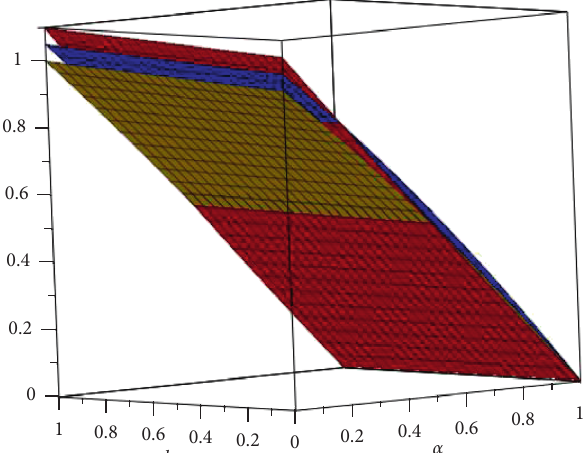
Figure 10: S index of three TraIFNs 􏽥 A , 􏽥 B , and 􏽥 C α ,k